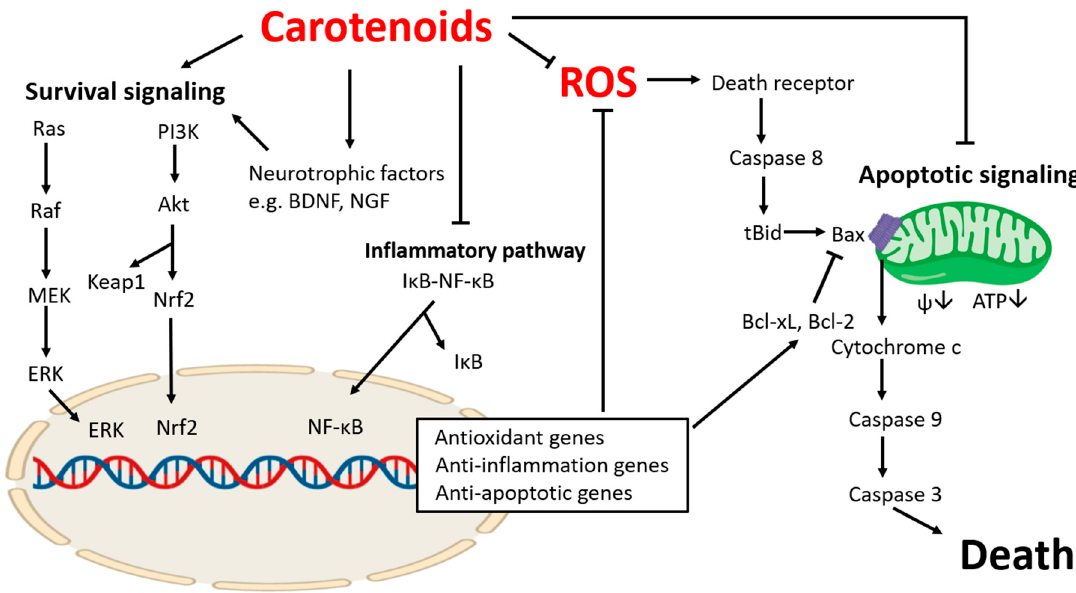
Figure 1. Protective roles of carotenoids during neuronal apoptosis. ROS: reactive oxygen species. ROS can trigger both death receptor- and mitochondria-mediated apoptotic pathways. As an antioxidant, carotenoids scavenge ROS to prevent ROS-induced apoptotic pathways. Carotenoids manipulate numerous cell-signaling pathways including Erk, Akt, and NF- κ B to enhance transcription of genes that promote antioxidant defense, anti-inflammation, and anti-apoptosis, illustration done using BioRender.